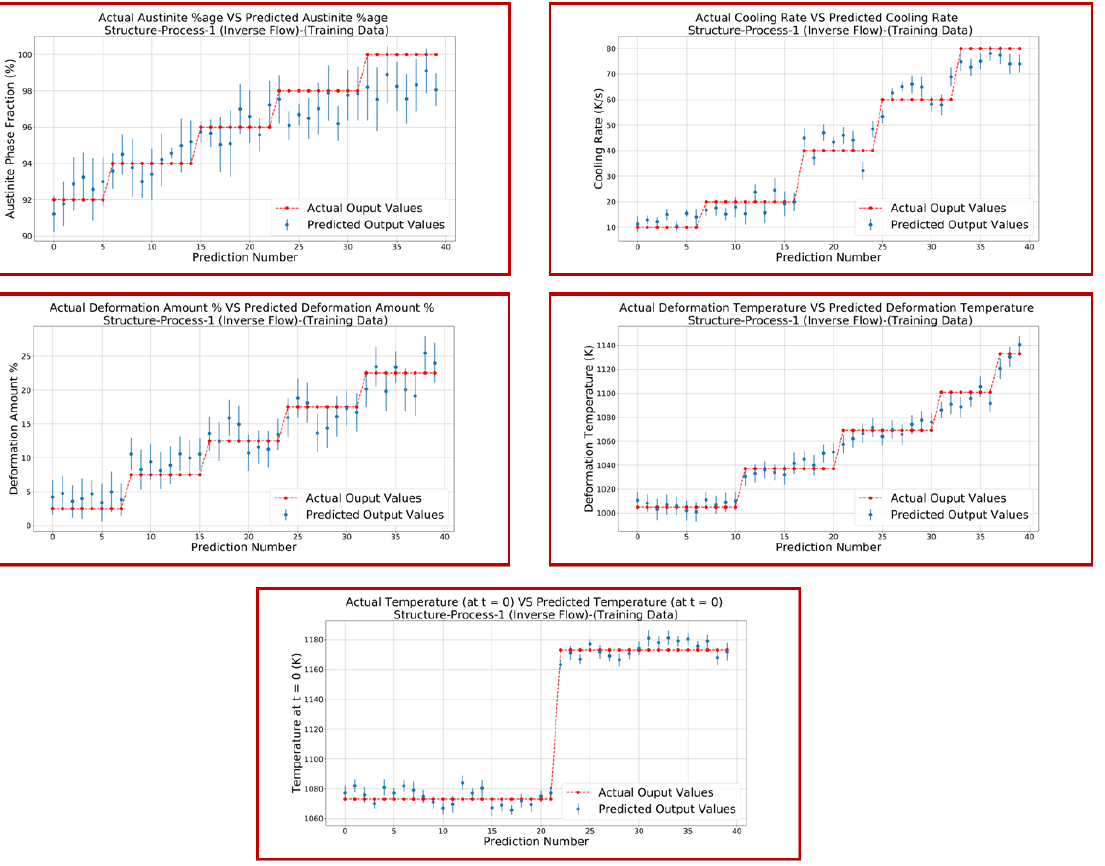
Figure 10. Predicted Output and Actual Output Comparison for Step 3.1 (for Input Dataset). Table 11. Processing Parameter Combinations Satisfying Microstructure Requirements .